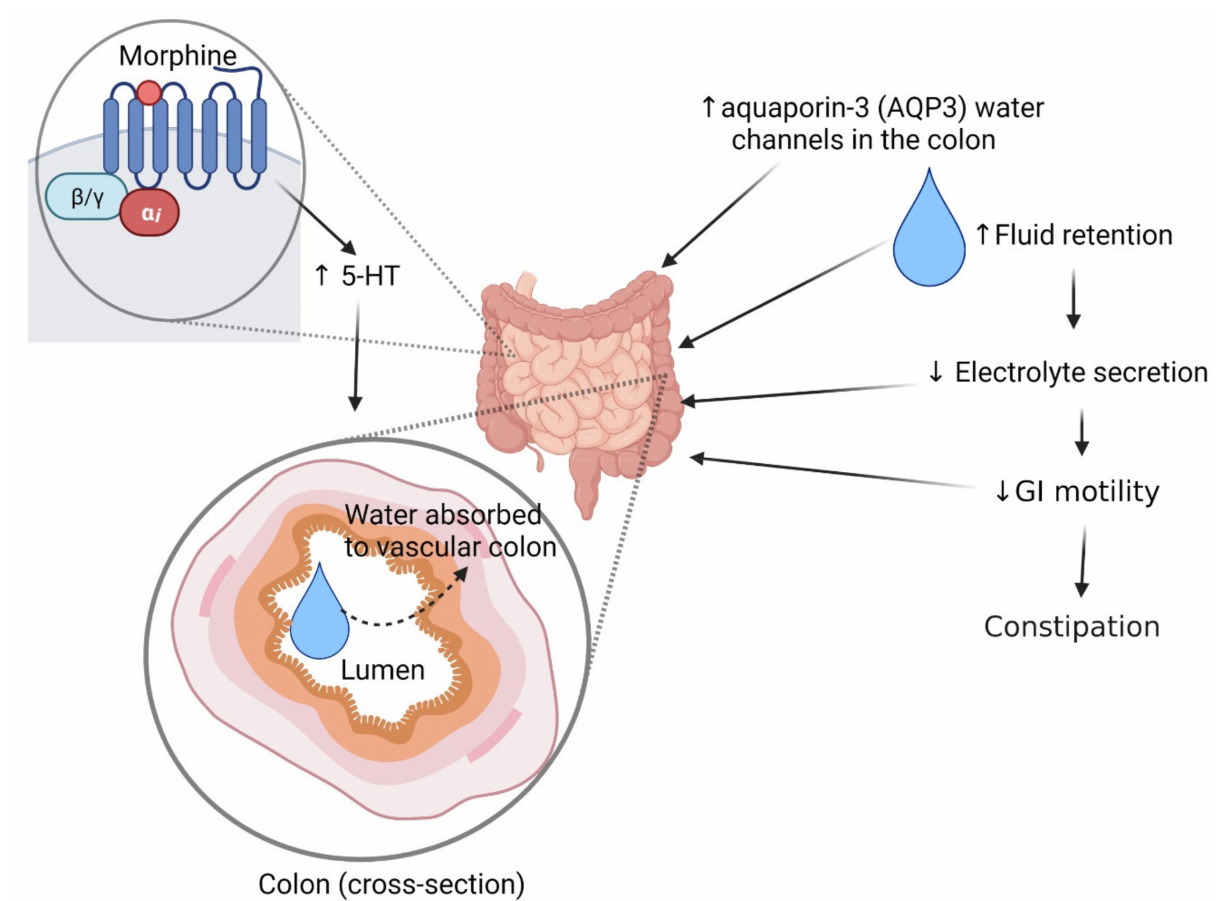
Figure 3. Effects of opioids in the gastrointestinal tract. Abbreviations: 5-HT, serotonin; GI, gastrointestinal. Symbols: solid arrow, strongly connected; dashed arrow, moderately connected; upward arrow (symbol), increased effect; downward arrow (symbol), decreased effect. The figure was made with www.biorender.com (accessed on 19 October